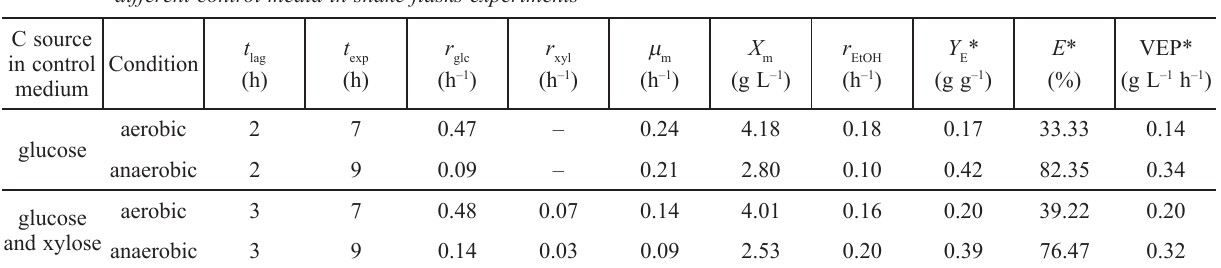
Table 3 – Bioprocess efficiency parameters of the aerobic and anaerobic cultivation of genetically engineered yeast S. cerevisiae on different control media in shake flasks experiments C source in control Condition medium glucose glucose and xylose